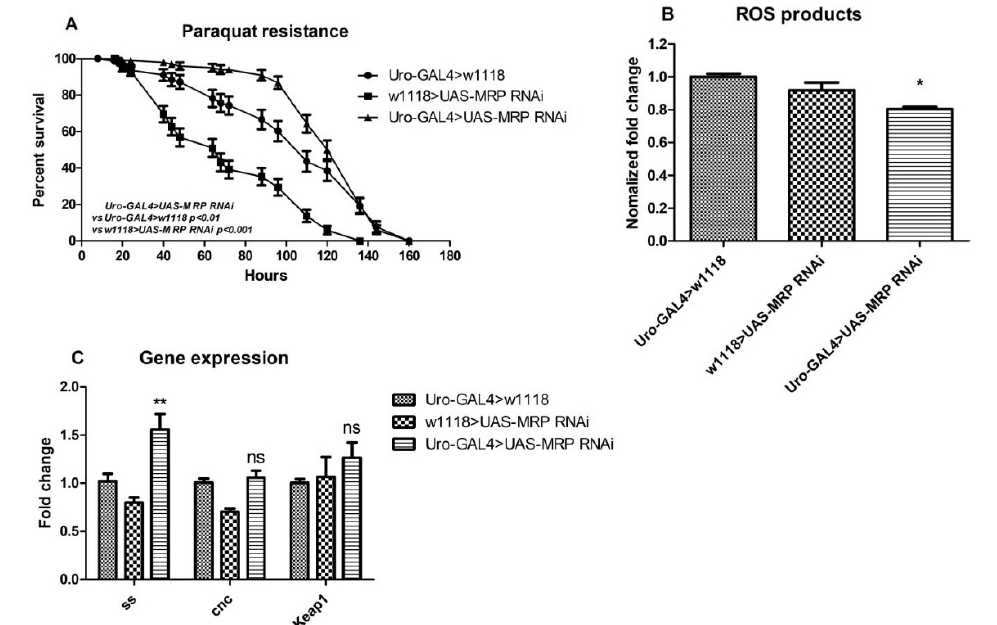
Figure 4. Malpighian tubule specific MRP knockdown conferred oxidative stress resistance. Flies 5–7 days of age were used. ( A ) Thirteen to fifteen flies were placed in a vial with a filter paper soaked with paraquat–sucrose solution. The death of flies was registered 3 times per day. The Uro-GAL4 > UAS-MRP RNAi flies exhibited more resistance to paraquat than both of the control groups (6–8 replicates were used for each group of flies; data are represented as percentage survival ± SEM; p values were shown on the plot; Kaplan–Meier log-rank test was performed). ( B ) ROS production of the Uro-GAL4 > UAS-MRP RNAi flies was significantly less than that of both of the controls, which indicates diminished oxidative stress level. Six flies were used for each replicate and 6 replicates were prepared for each group. The data were normalized to the Uro-GAL4 > w 1118 group. ( C ) The expression of ss , cnc , and Keap1 were tested using qPCR. Although no difference was observed in cnc and Keap1 expression, ss expression levels increased significantly in the experimental flies. The graph represents as mean ± SEM; * p < 0.05, ** p < 0.01; one-way ANOVA with Tukey’s post hoc test was